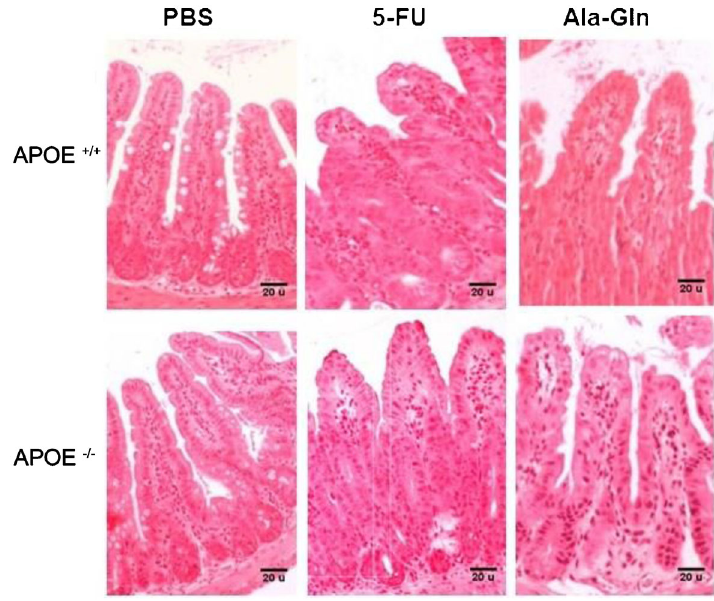
Figure 3. Representative histology of H&E- stained ileal tissue (100 6 ) from experimental mice with 5-fluorouracil-induced intestinal muco- sitis (5-FU, 450 mg/kg, ip , single dose), and mice treated with alanyl-glutamine (Ala-Gln, 100 mM) or phosphate buffered saline (PBS) via gavage on day 6